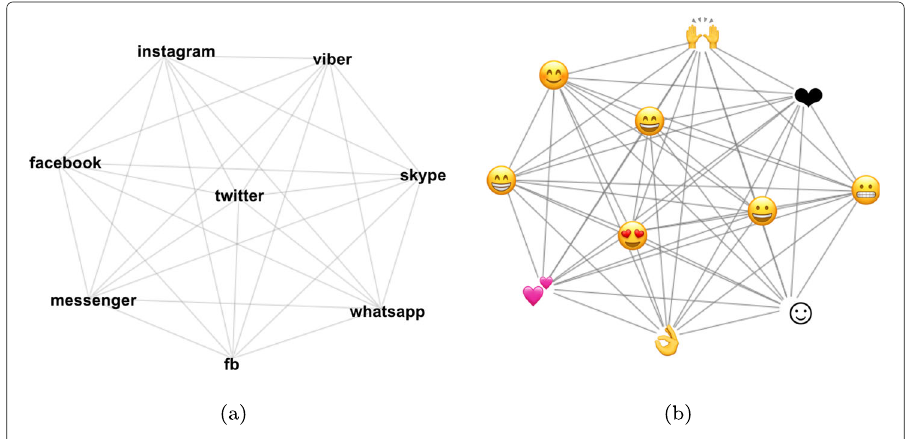
Fig. 5 Maximum cliques containing in an ego network of a ) word “twitter” (similarity cutoff=0.65), b ) “grinning face with smiling eyes” emoji (similarity cutoff=0.55). The network of words is constructed using the word embedding of Amazon Reviews dataset